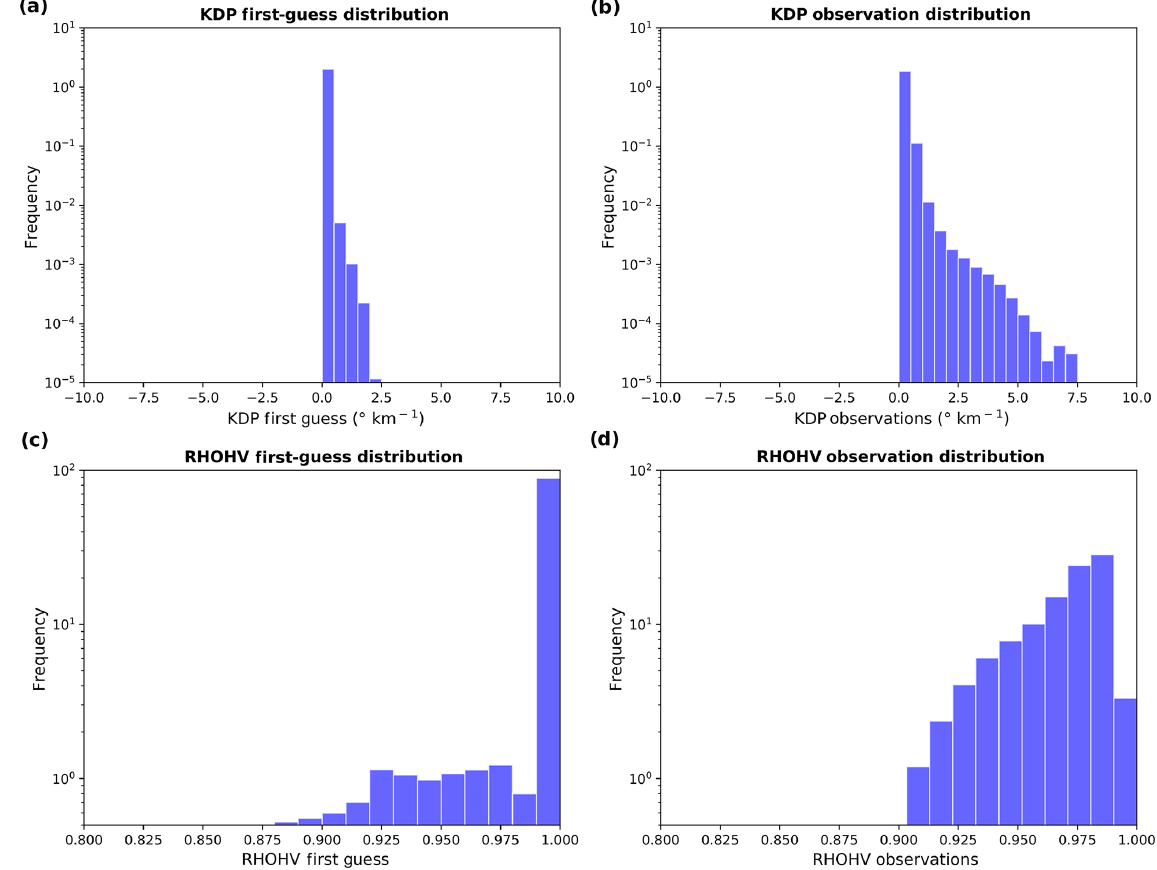
Figure 8. Same as Fig. 7 for K DP (a, b) and for ρ HV (c, d) .